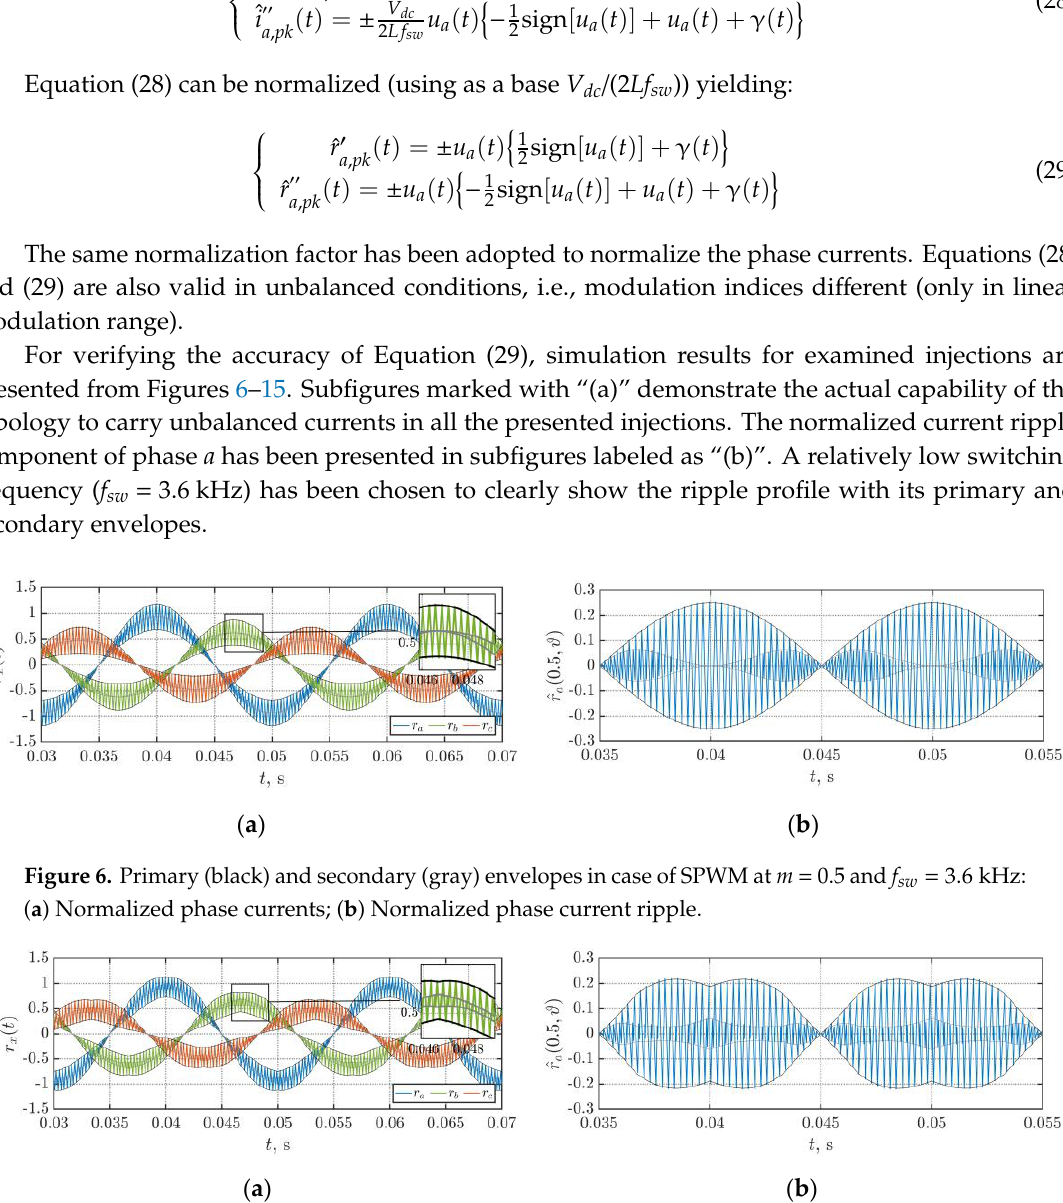
Figure 7. Primary (black) and secondary (gray) envelopes in case of CPWM at m = 0.5 and f sw = 3.6 kHz: ( a ) Normalized phase currents; ( b ) Normalized phase current ripple.